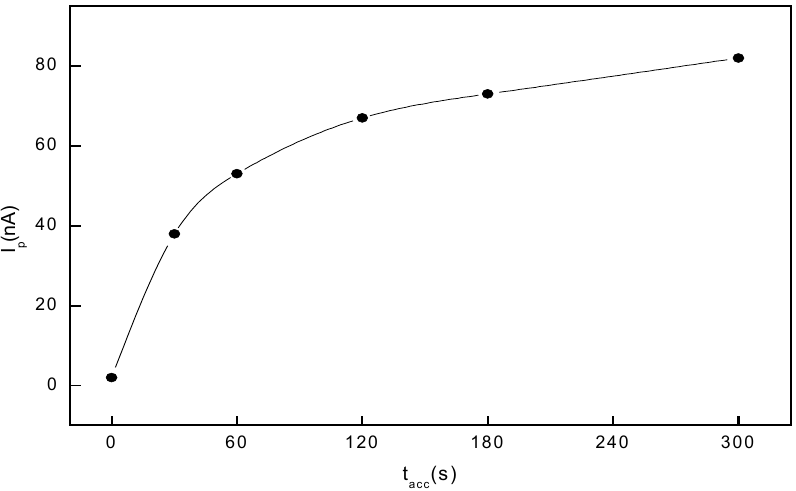
Figure 4. Voltammogram of 2.10 -7 mol.L -1 1-AP with adsorptive accumulation in stirred solution of a BR buffer pH 2 : MeOH (9:1 v/v) (1) and of the supporting electrolyte (2), E = 200 mV, t = 60 s. acc acc